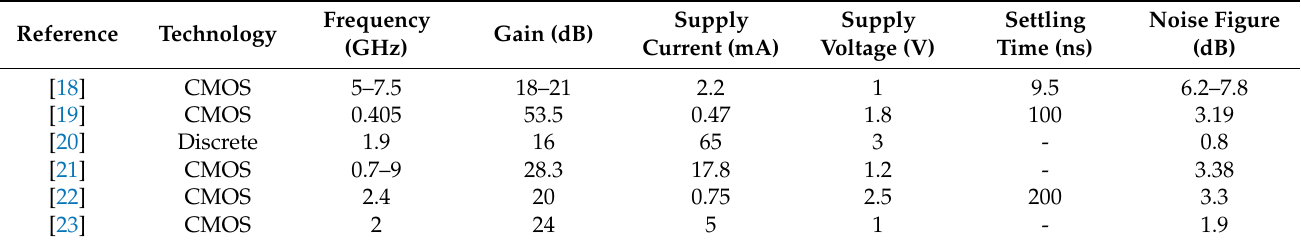
Table 1. Selection of different LNA designs operating in different frequency